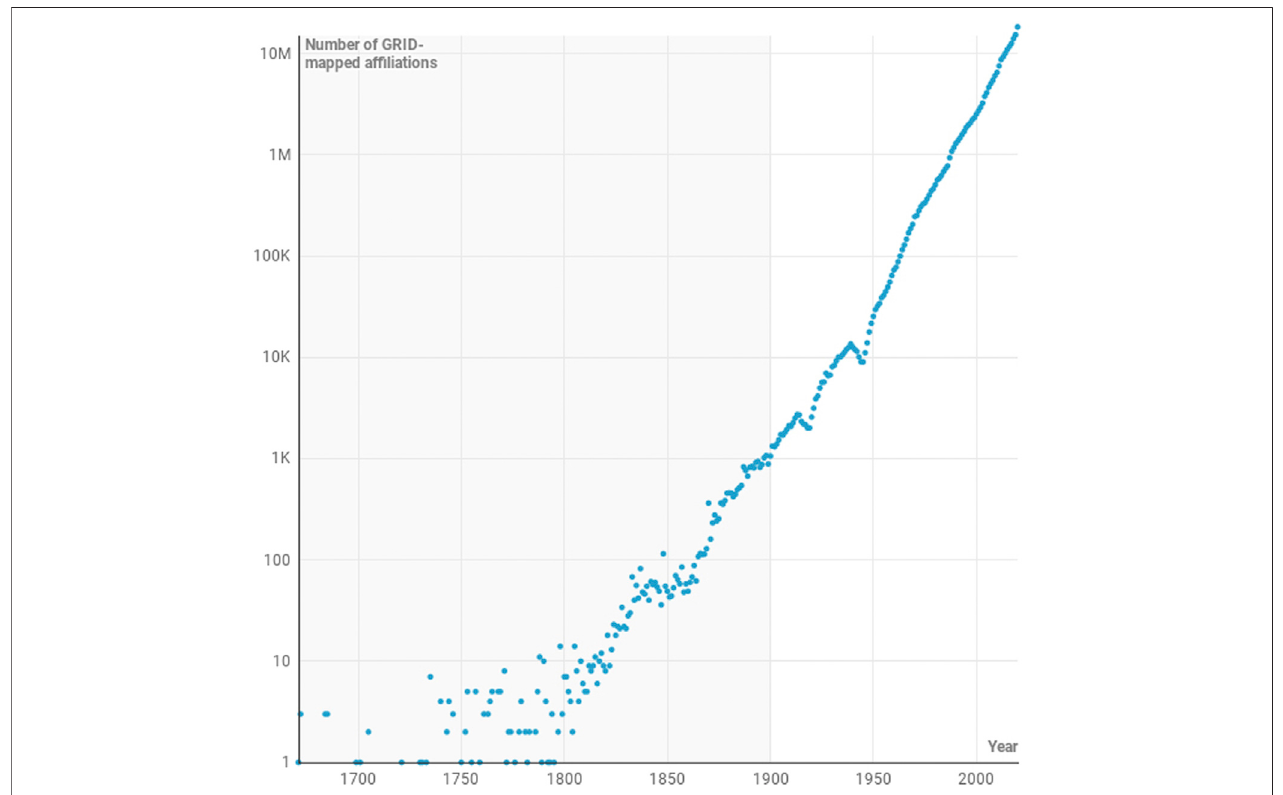
FIGURE 1 | Logarithmic-scaled plot of the number of GRID-mapped institutions associated with papers in the dimensions database by year from 1671 to 2020. Thetwonotabledipsinthedatainthe fi rsthalfofthe20thCenturyco-incidewiththetwoworldwars.Thegreybackgroundhighlightstheregionbetween1671and1990 in which the number of contributing records is taken to be too small to give a stable basis for statistical analysis.